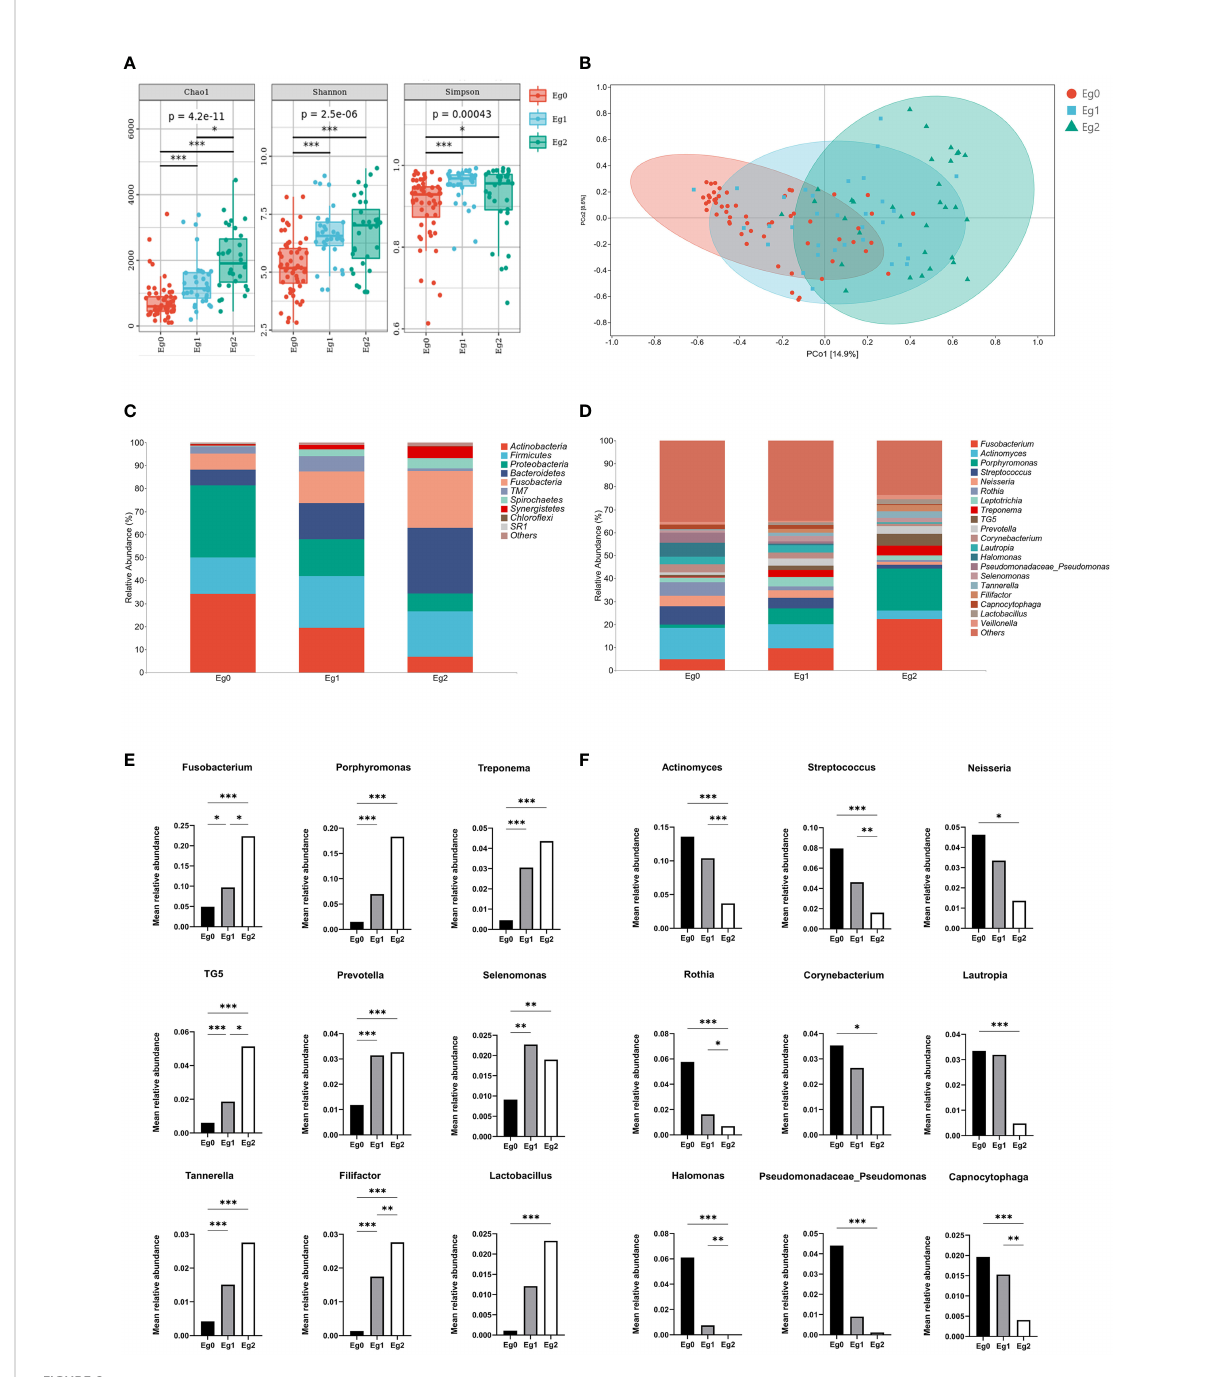
FIGURE 2 Alterations in bacterial diversity and community structure among Entamoeba gingivalis ( E. gingivalis ) subgroups. (A) Comparison of bacterial alpha diversity by Chao1, Shannon index, and Simpson index among the E. gingivalis subgroups. (B) Structural discrepancy in microbial communities by principal coordinate analysis based on Weighted UniFrac distance among the E. gingivalis subgroups. The 95% con fi dence ellipses show the separation of microbial communities among the E. gingivalis subgroups. (C) Barplot showing the bacterial proportion at the phylum level among the E. gingivalis subgroups. The top 10 most abundant phyla are exhibited. (D) Barplot showing the bacterial proportion at the genus level among the E. gingivalis subgroups. The top 20 most abundant genera are exhibited. (E, F) Signi fi cantly increased and decreased bacteria of the top 20 abundant genera among the E. gingivalis subgroups. Eg0, E. gingivalis negative group (n=56). Eg1, E. gingivalis low- abundance group (relative abundance <10%, n = 32). Eg2, E. gingivalis high-abundance group (relative abundance ≥ 10%, n=32). Data are represented by the mean relative abundance and determined by the Kruskal – Wallis test. *p < 0.05, **p < 0.01, ***p <